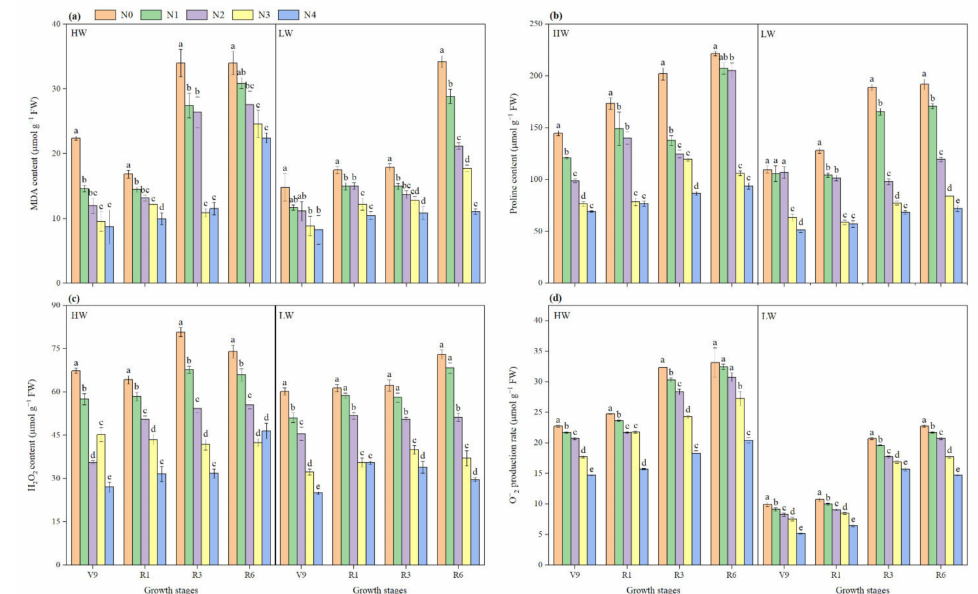
Figure 4. Effect of irrigation and nitrogen rates on malondialdehyde (MDA) content ( a ), proline content ( b ), H 2 O 2 content ( c ), and O 2 content ( d ). HW and LW represent the irrigation water at the rate of 80 and 60% of field capacity. Means followed by different lowercase letters within each treatment indicate significant differences ( p < 0.05). The bar represents the standard error. The nitrogen treatments N0, N1, N2, N3 and N4 represent the application of nitrogen at the rate of 0, 200, 250, 300 and 350 kg ha − 1